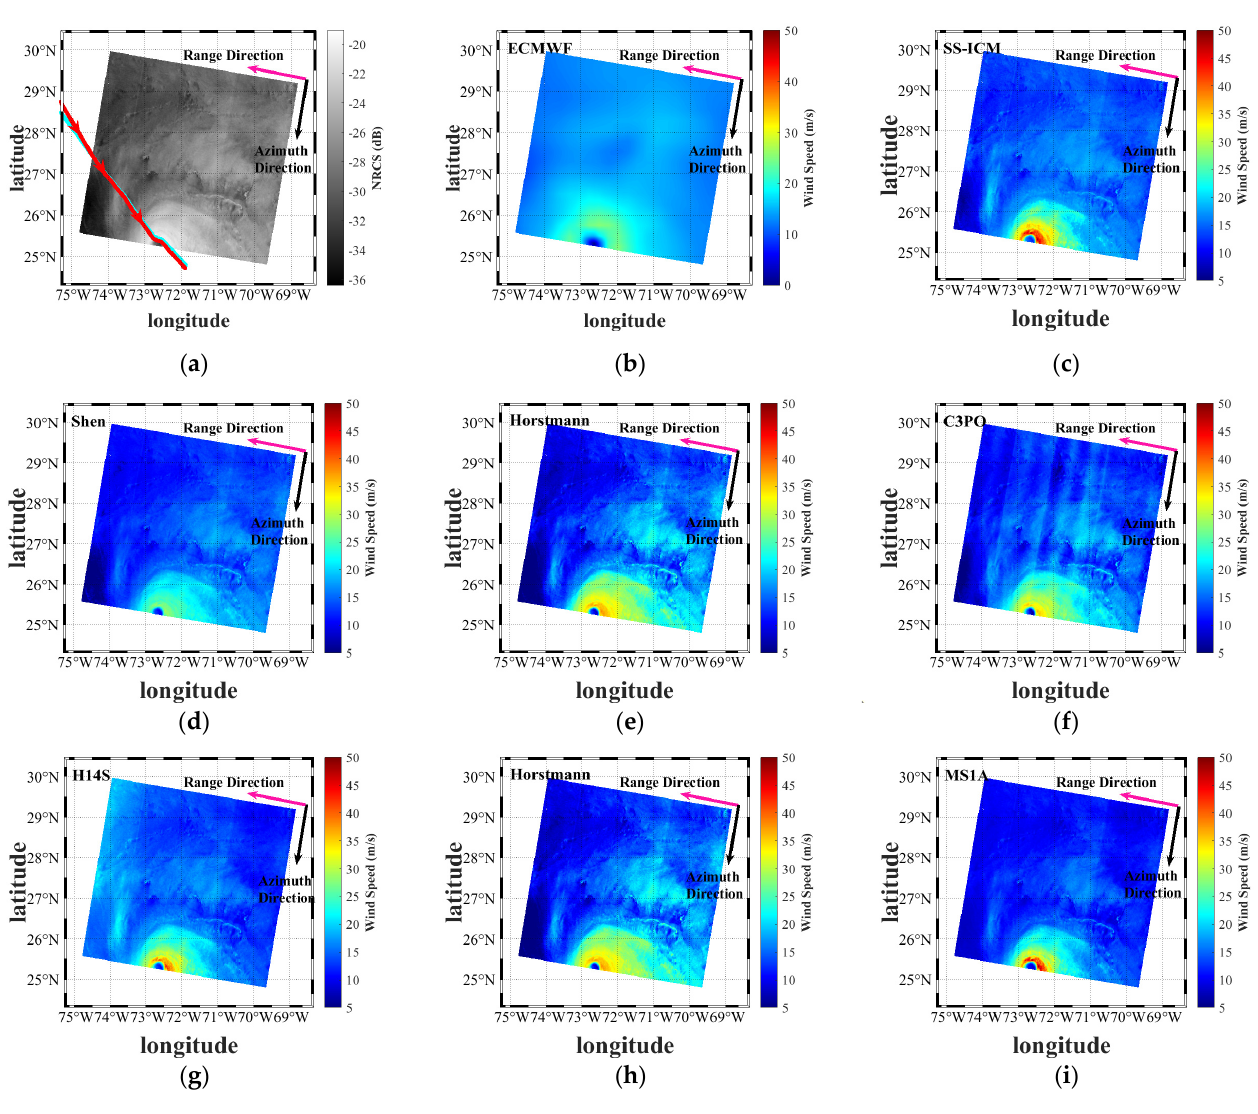
Figure 13. The wind speed retrieved by different GMFs. ( a ) SAR image of TC Joaquin; ( b ) the wind speed from the ECMWF reanalysis data; the retrieved wind speed by ( c ) SS-ICM model, ( d ) Shen model, ( e ) Horstmann model, ( f ) C3PO model, ( g ) the H14S model, ( h ) H14E model, and ( i ) MS1A model.